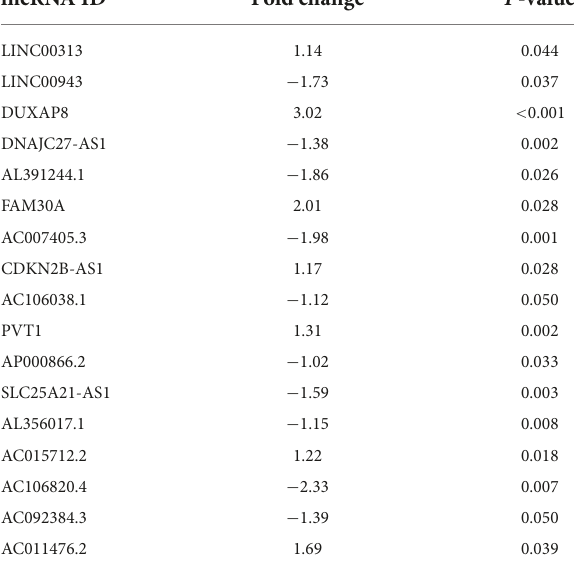
( Figure 6E ). Immunohistochemistry showed that SLC39A14 ( Figure 6F ) and SLC2A3 ( Figure 6G ) were significantly increased in IA